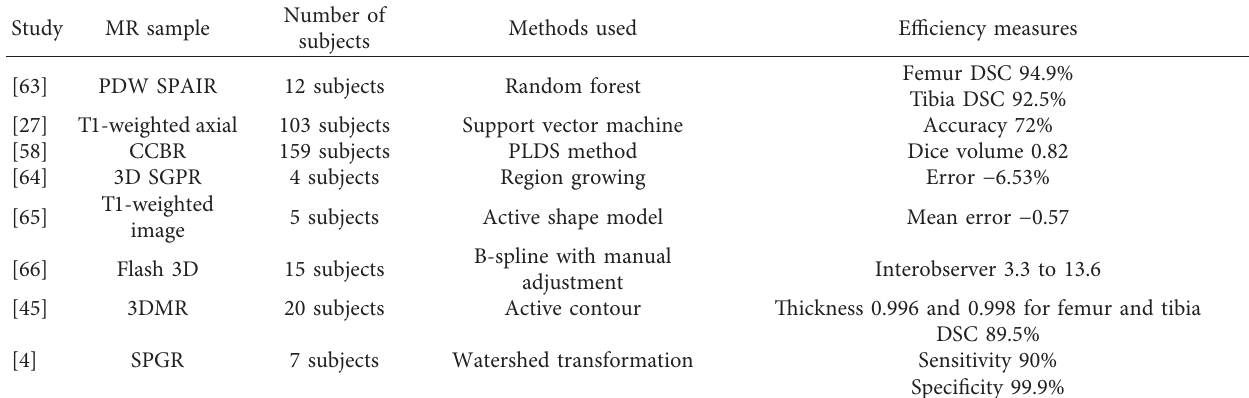
Table 2: Semiautomated segmentation